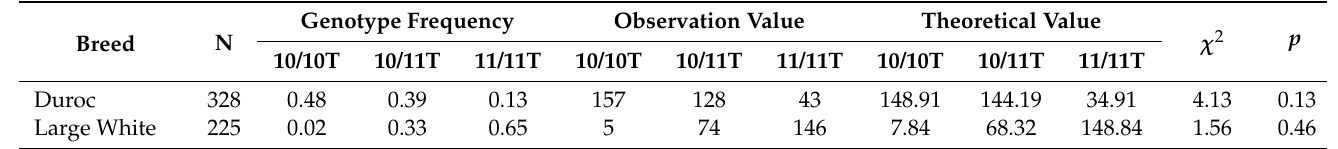
Table 4. Genotypic frequency of tract 2 on IGF1 among commercial pigs.